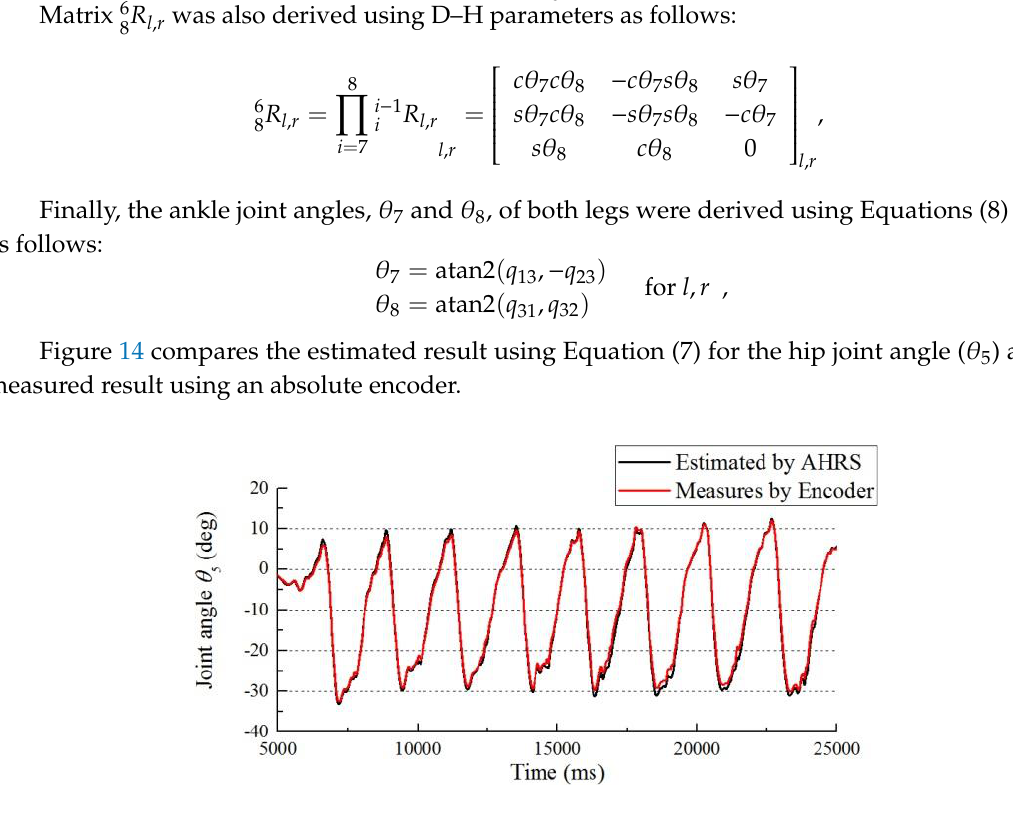
Figure 14. Joint angle estimation result of θ 5 compared with the angle measured by an encoder.